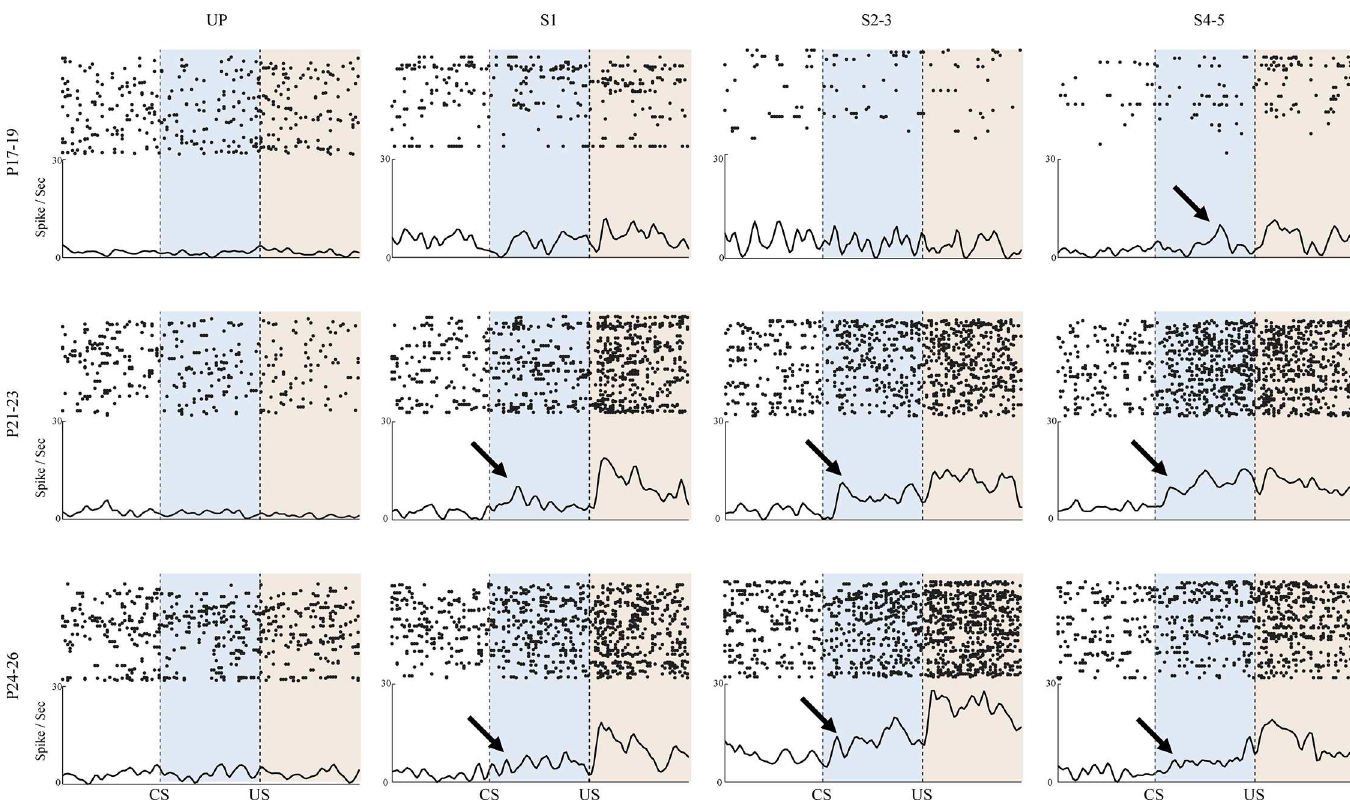
Fig 6. Representative examples of CA1 pyramidal cell firing. Examples of CA1 single pyramidalcell firing during eyeblinkconditioning in rat pups given eyeblinkconditioning on postnataldays (P) 17–19, P21-23, or P24-26. Rastergramsand perievent time histograms (PETH; bin size = 10 ms) of single neuronsrecorded during the unpaired(UP) session and followingpaired sessions (S1, S2-3, and S4-5). The neurons in the P17-19 group tended to fire randomly across the CS and US presentations until S2-3. In contrast, neurons in the older age groups showed increasedfiring rates during the post-US period as early as S1 and showed increasedfiring rates in the CS and post-US period as early as S2-3. Arrows note the start of significantlyincreased activity during the